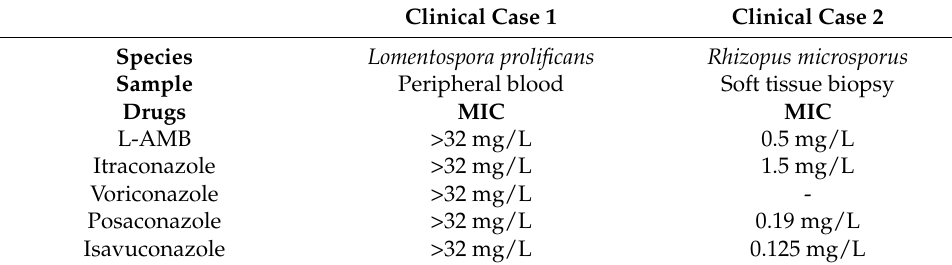
Table 1. In vitro antifungal susceptibility